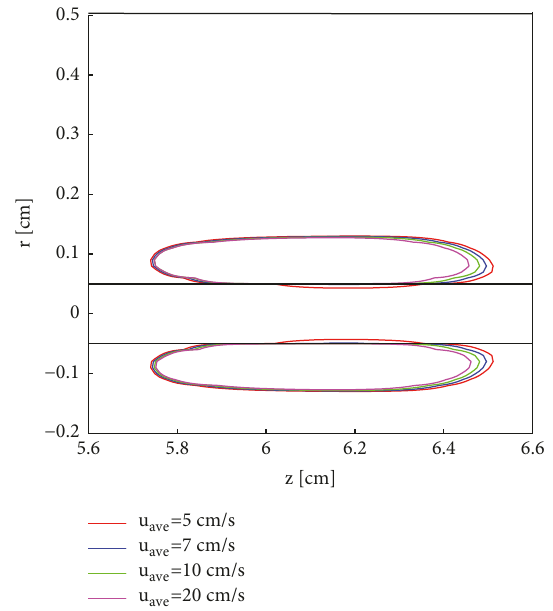
Figure 11: Thermal lesion region in space 𝑟, 𝑧 ∈ Ω with different average velocity of blood flow for 𝑝 0 = 2 × 10 5 𝑝𝑎 , 𝑟 0 = 0.5 𝑚𝑚 , 𝑑 = 0 𝑚𝑚 , 𝜏 = 1.756 𝑠 , 𝑓 = 1 𝐻𝑧 , 𝑓𝑎𝑐 = 0.5 , 𝑡 = 2𝑠 . 𝑝 ℎ